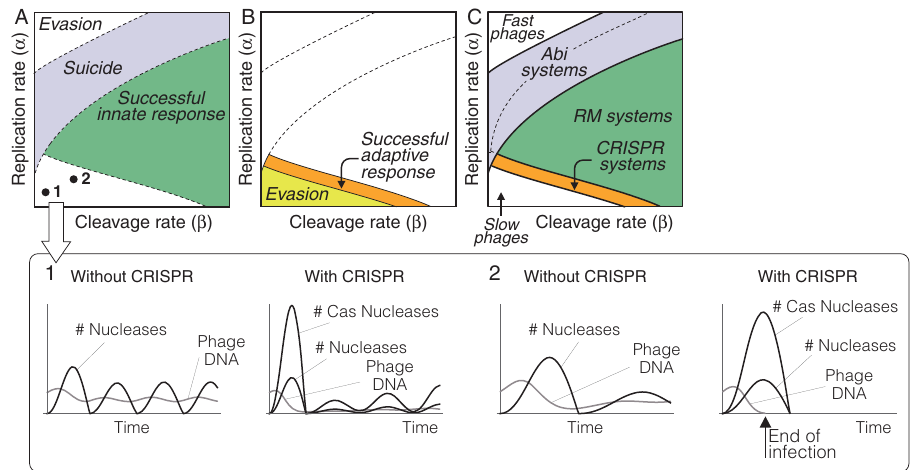
Fig. 4 | Role of the CRISPR systems in anti-phage responses. A Within-cell dynamics of slow phage infections in bacterial cells with and without CRISPR sys- tems(assimulatedbyModel3andModel2,respectively).TheactivationofCRISPR nucleasesinaninfectedbacterialcellincreasestherateofphageDNAdegradation. This does not affect some phages that can still cause sustained infections of their host (1). In other cases, the increase in the rate of DNA cleavage due to CRISPR nucleasescanentailtheendoftheinfectionofthebacterialcell(2).Inthiscase,the CRISPR system could allow bacterial cells to eliminate slow phages that would